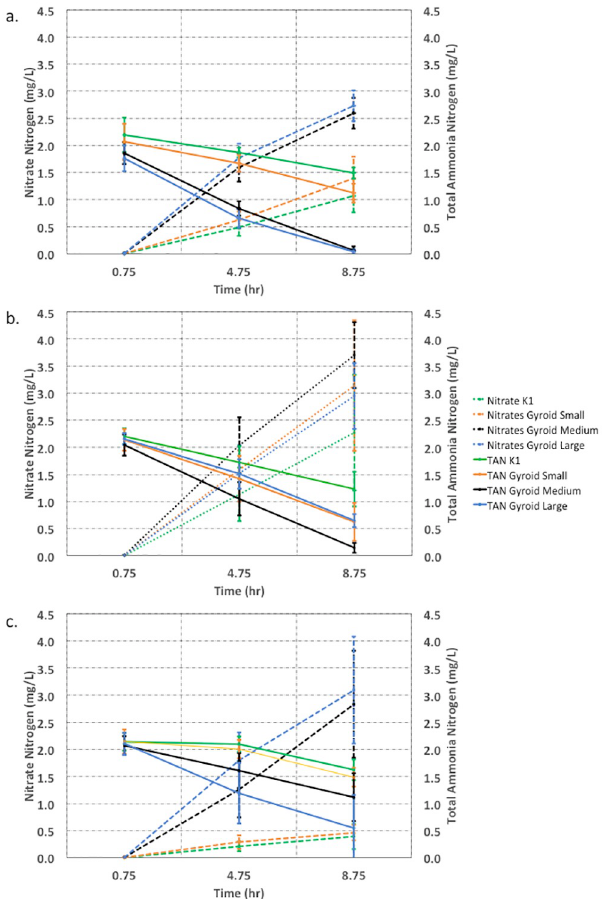
Fig 4. Pooled results for total ammonia nitrogen and nitrate nitrogen concentrations over time for (a) Experiment 1, constant biocarrier fill ratio; (b) Experiment 2, constant biocarrier total surface area; (c) Experiment 3, constant biocarrier count. Error bars represent standard